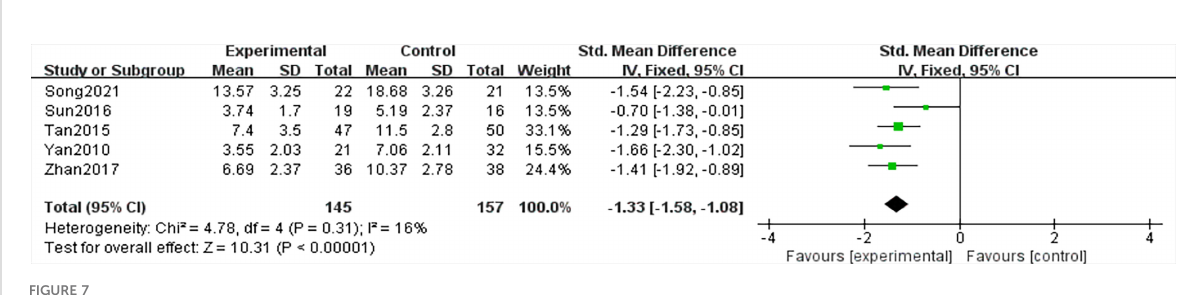
FIGURE 7 Forest plot of TCM syndrome integral comparison.